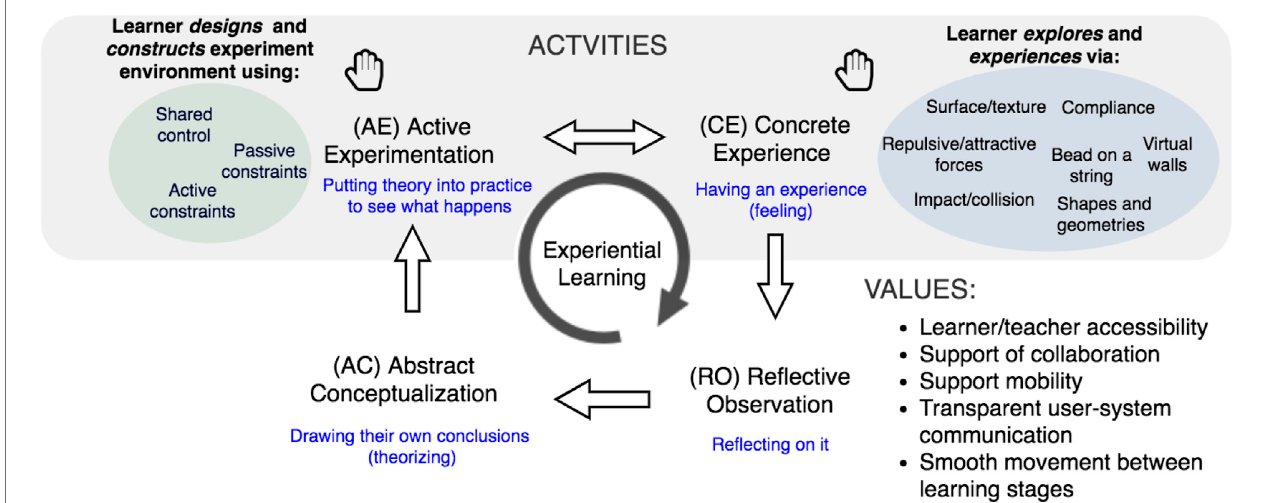
FIGURE 1 | The PAL Framework. Physically Assisted Learning interactions haptically adapt stages of experiential learning from Kolb (1984) ’ s general framework, with some added features from Honey and Mumford (2000). Hands-on Active Experimentation and Concrete Experience are most amenable to haptic augmentation, enriching the more purely cognitive Re fl ective Observation and Abstract Conceptualization.